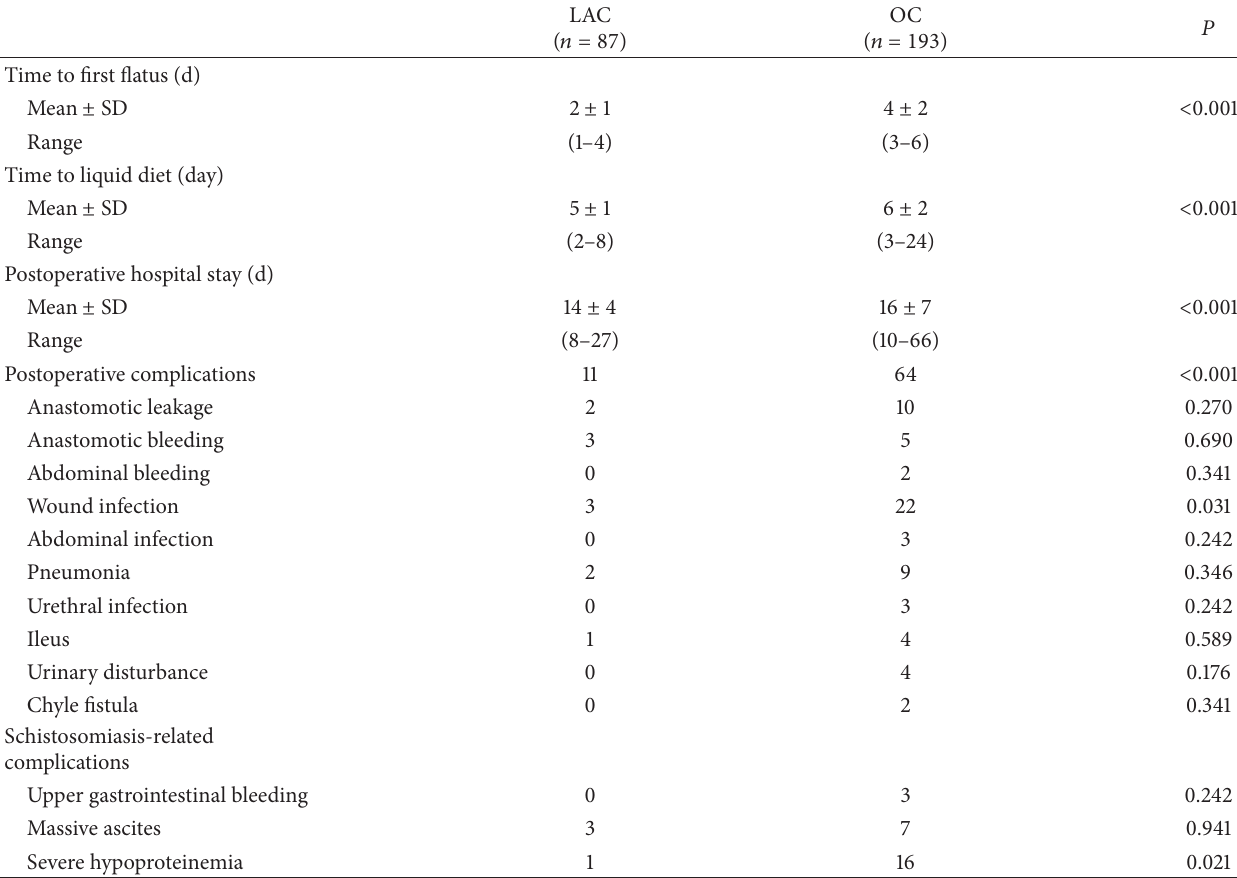
Table 4: Perioperative